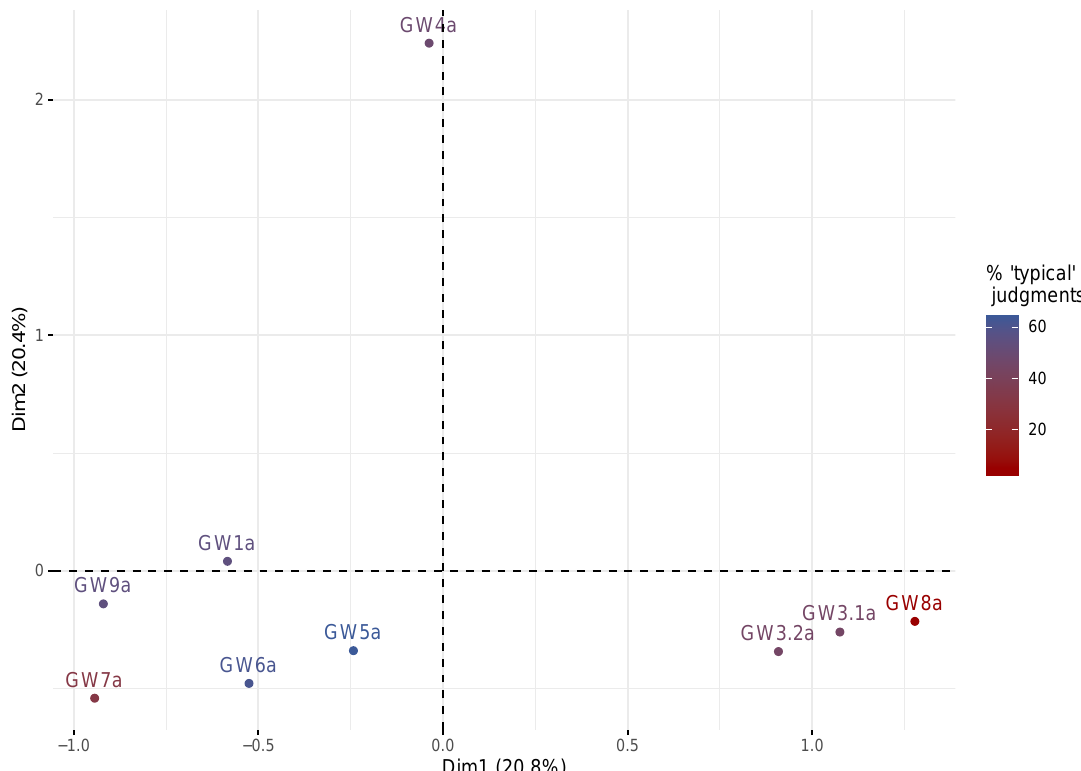
Figure 3. Multiple Correspondence Analysis of the Gwell sorting task performed by the non-expert jury. Each sample is colored according to the percentage of times it had been considered to be typical during the previous